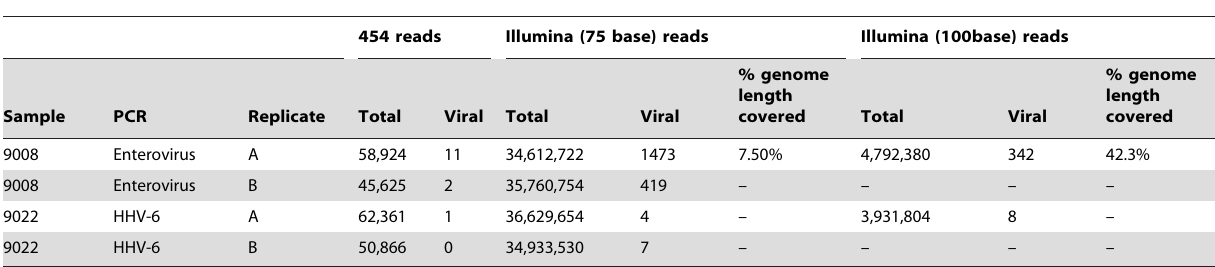
Table 1. Detection of viruses with next generation sequencing.